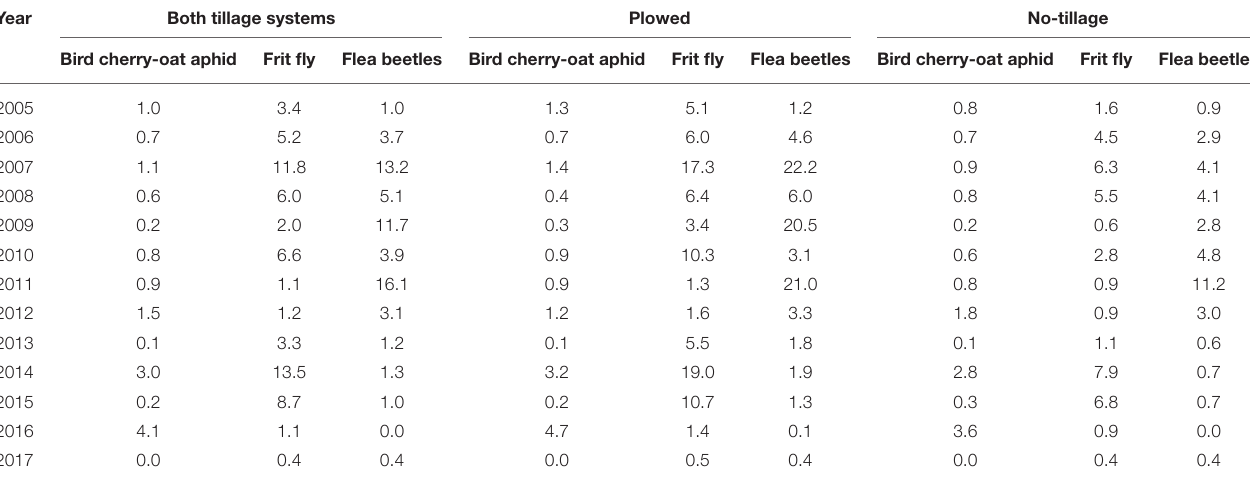
TABLE 10 | Abundance of pest insects in spring wheat monitored with yellow sticky traps in 2005–2017. Year Both tillage systems Plowed No-tillage Bird cherry-oat aphid Frit fly Flea beetles Bird cherry-oat